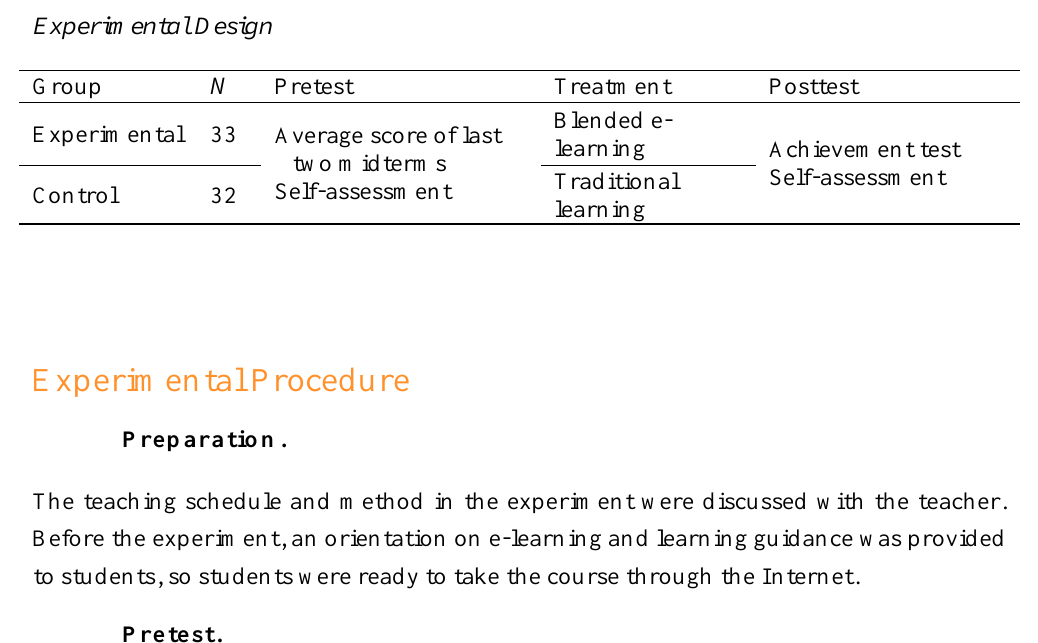
Experimental Design Group N Pretest Treatment Posttest Blended e- Experimental 33 Average score of last learning Achievement test two midterms Self-assessment Traditional Self-assessment Control 32 learning